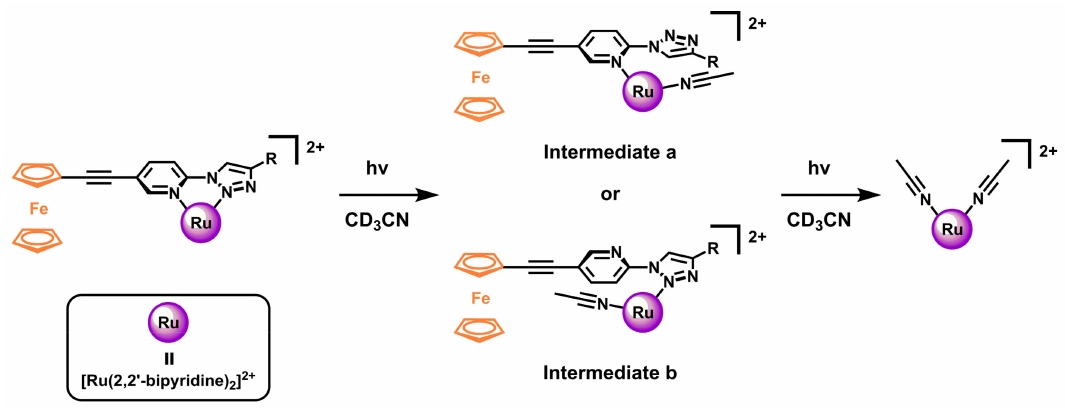
Figure 7. Partial stacked 1 H NMR spectra (400 MHz, CD 3 CN, 298 K), showing the photo-ejection of [Ru(bipy) 2 (CD 3 CN) 2 ] 2+ (blue dashed lines) from L4Ru (red dashed lines) over time under UV (254 nm) irradiation; ( a ) 1 H NMR of unirradiated L4Ru , ( b – d ) 1 H NMR of L4Ru after 1–3 days of UV irradiation, and ( e ) 1 H NMR of independently synthesised [Ru(bipy) 2 (CH 3 CN) 2 ](BF 4 ) 2 . Note: L4 is insoluble in acetonitrile, hence, no spectrum of a free ligand for